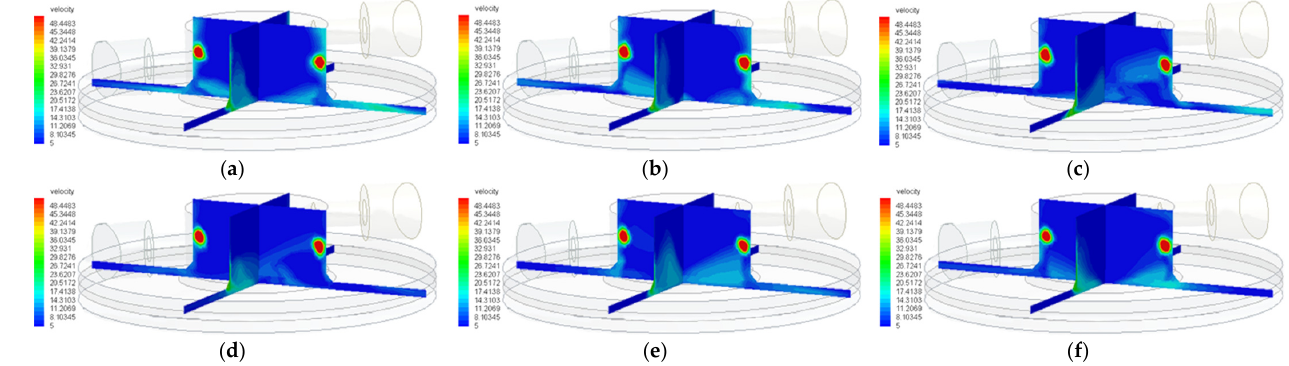
Figure 28. When inlet pressure = 15 MPa, gap = 1.5 mm, the variation of velocity of suction cup- θ 20 with time in vertical axial cross planes at: ( a ) 5 ms, ( b ) 9.4 ms, ( c ) 13.8 ms, ( d ) 18.2 ms, ( e ) 22.6 ms, and ( f ) 27 ms.